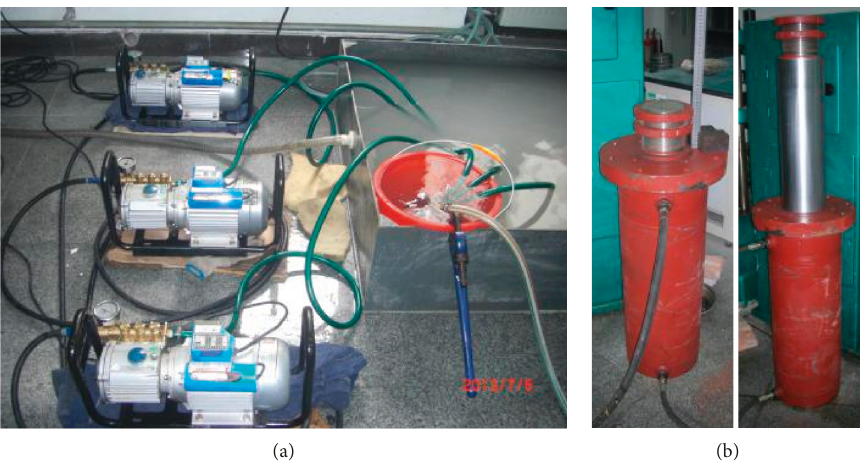
Figure 5: The (a) quantitative displacement piston pump and (b) double-action hydraulic cylinder.